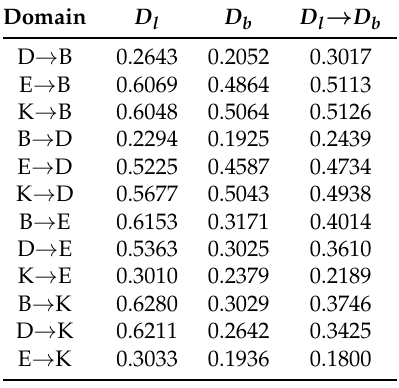
Table 3. Auxiliary dataset D bl for cross-domain product review sentiment